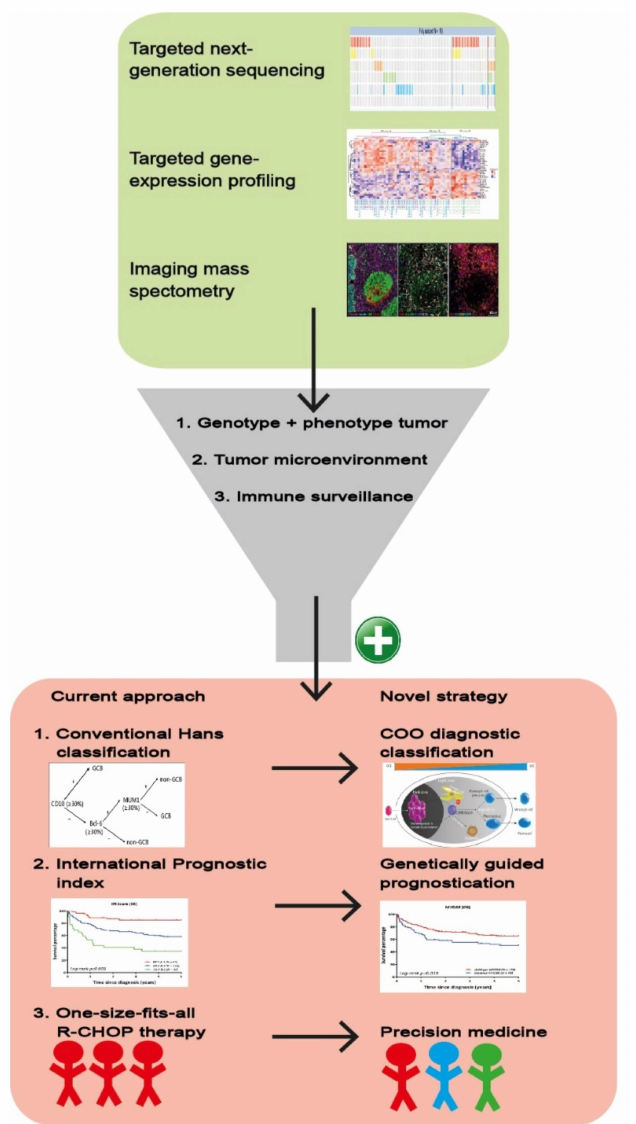
Figure 4. Schematic overview of a multilayered research strategy. Combining targeted NGS, targeted GEP and imaging mass spectrometry allows for inclusive analysis of genotype, phenotype, TME and immune surveillance of the DLBCL. This methodology substantiates the conversion from the current approach towards a novel strategy including (1) Hans classification to COO diagnostic classification, (2) a general clinical prognostic score (International Prognostic Index) towards a biology-guided prognostication and ultimately (3) facilitating development from a one-size-fits-all R-CHOP treatment towards more precision